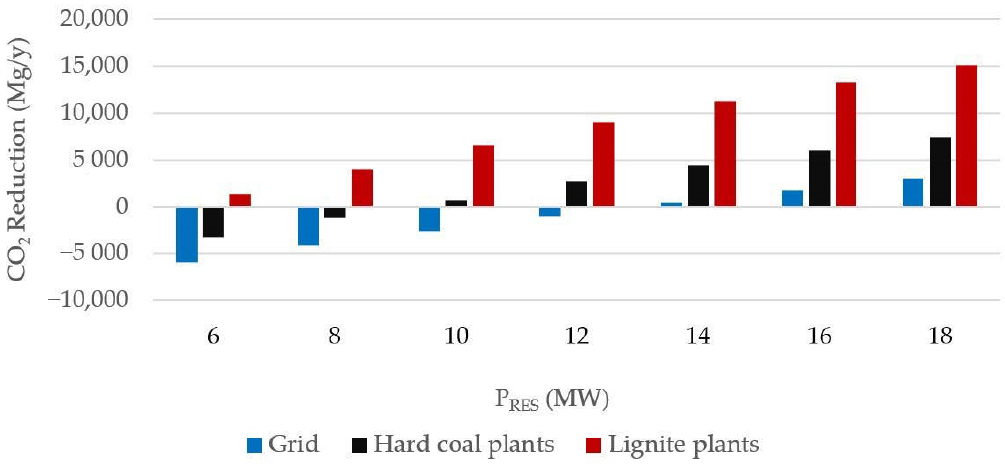
Figure 15. CO 2 emission reductions.